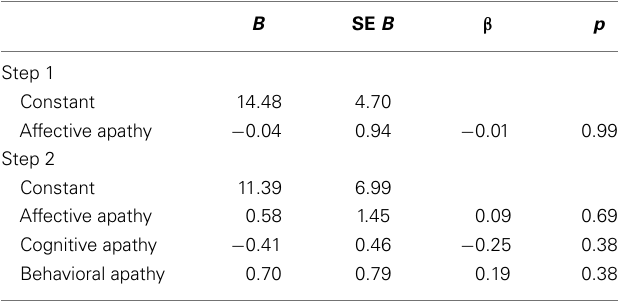
Table 4 |The relationship between apathy domains and depressive symptoms